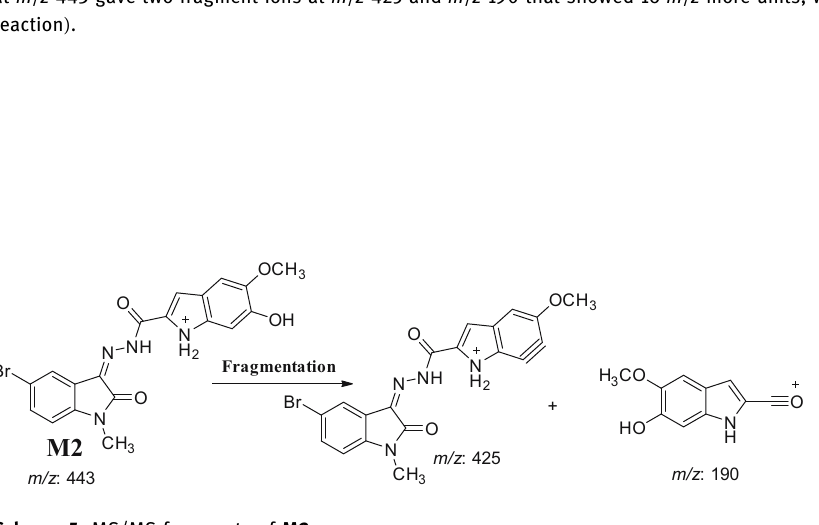
Scheme 5: MS/MS fragments of M2